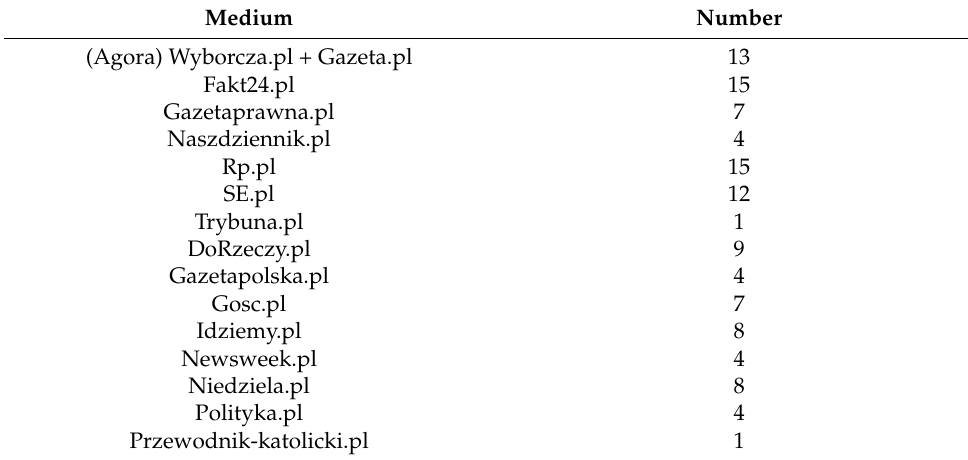
Table 2. The number of texts